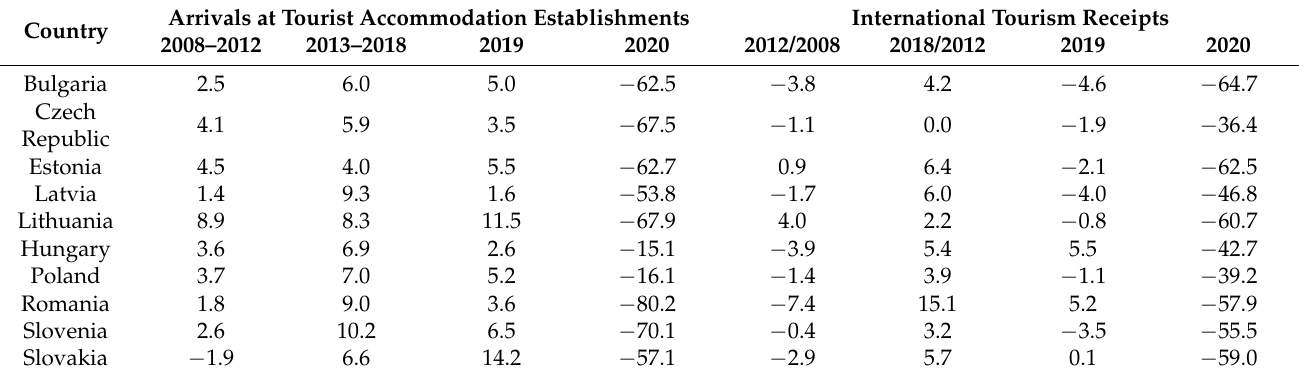
Table 1. Average annual growth of tourism activity in 2008–September 2020 (% change over same period of previous year) (Source: [32–34]) (Annex